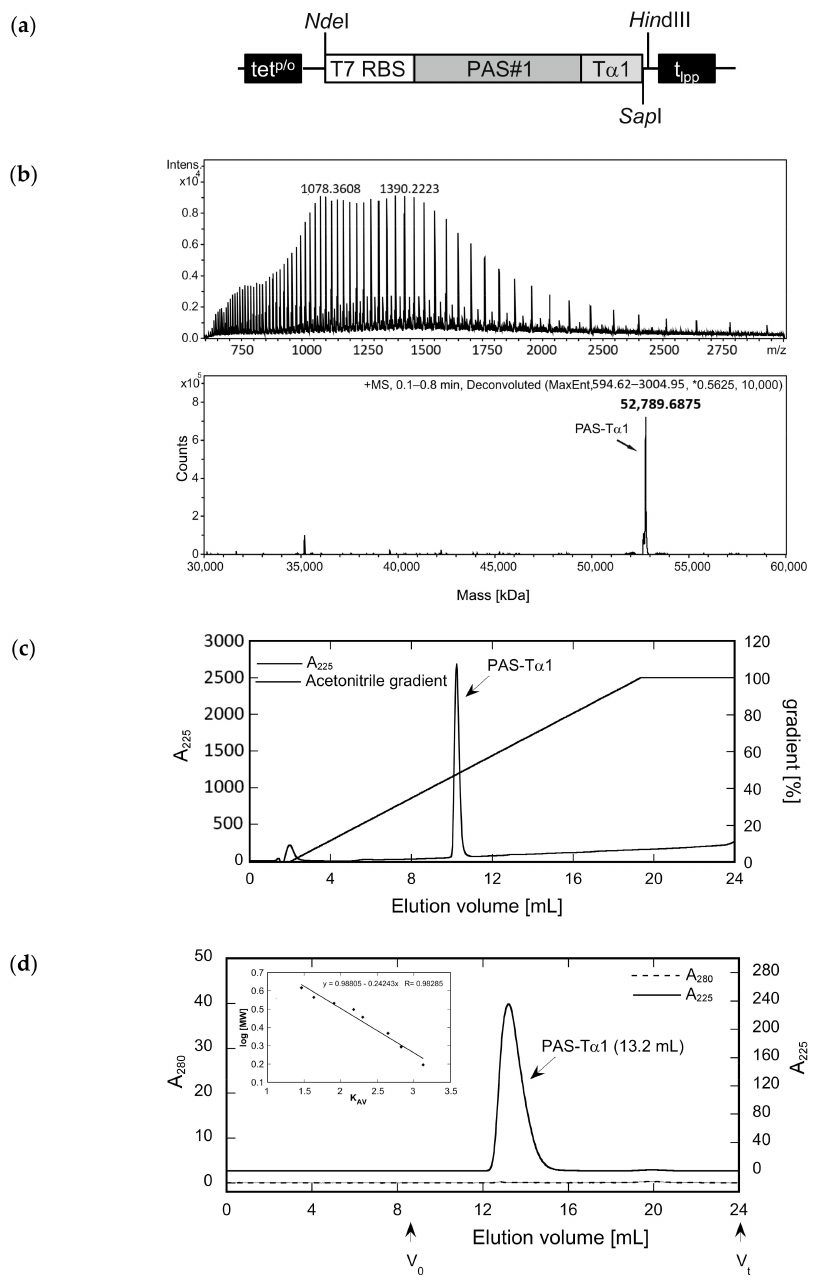
Figure 3. Preparation of an N-terminally PASylated version of the T α 1 peptide and analysis of its integrity, purity, and hydrodynamic volume. ( a ) Expression vector for the bacterial production of PAS-T α 1. The gene cassette cloned on pASK75 comprises the T7 RBS, the coding region for a 601-residue PAS#1 sequence preceded by a start methionine and a proline codon, the human T α 1 sequence, and, finally, t lpp . ( b ) The deconvoluted ESI-MS spectrum of PAS-T α 1 purified from the E. coli cell extract by subtractive AEX and CEX (see text) reveals a molecular mass of 52,789.69 Da, which matches the calculated mass for PAS-T α 1 with a fully processed start methionine (52,789.66 Da). ( c ) Reverse-phase chromatography indicates a purity > 96% for PAS-T α 1. ( d ) Analytical SEC of the purified PAS-T α 1 in PBS results in a single peak with an elution volume of 13.2 mL. Comparison with a half-logarithmic calibration curve (inset) indicates a strongly expanded hydrodynamic volume with an apparent molecular size of 665